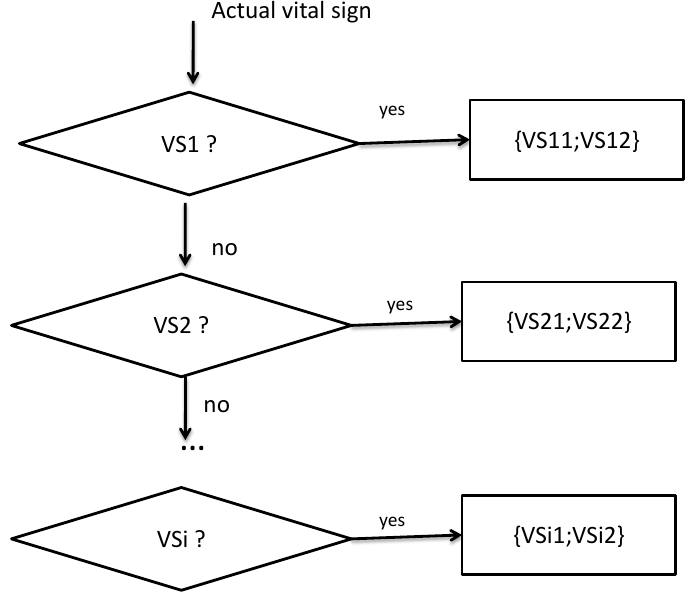
Figure 4. Correlation phase